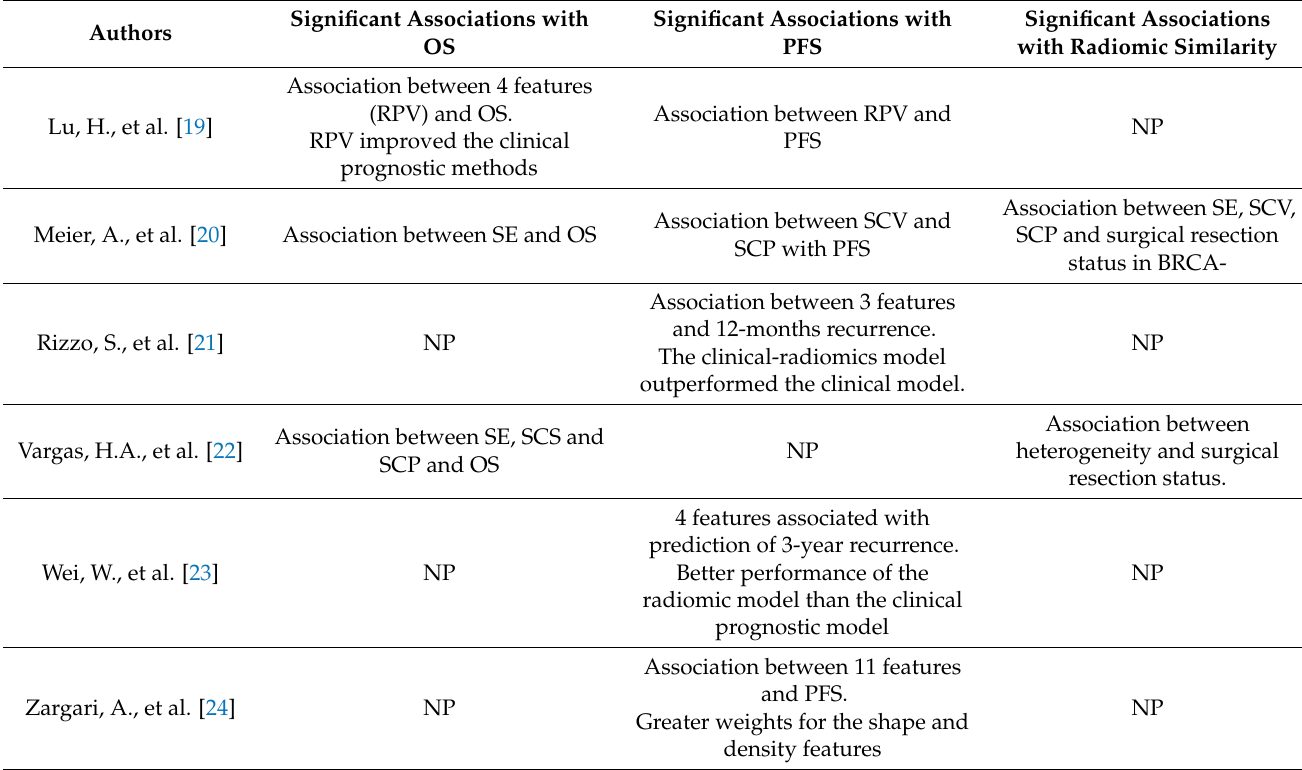
Table 4. Main Findings of the Included